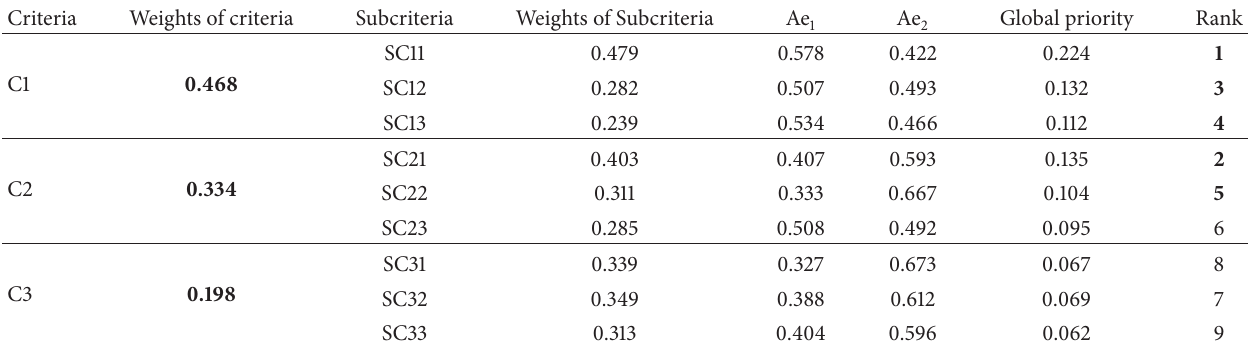
Table 1: Eigenvectors and weights of two business strategies’ rank under nine subcriteria. Criteria